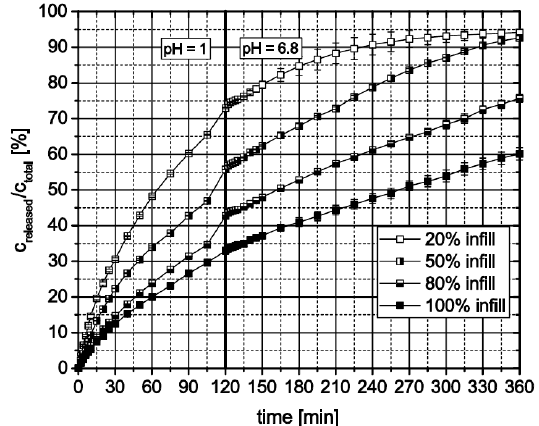
Figure 12. In vitro theophylline release from HPMC15 3D-printed cylinders with different open porosity defined via “infill” setting, n = 3.